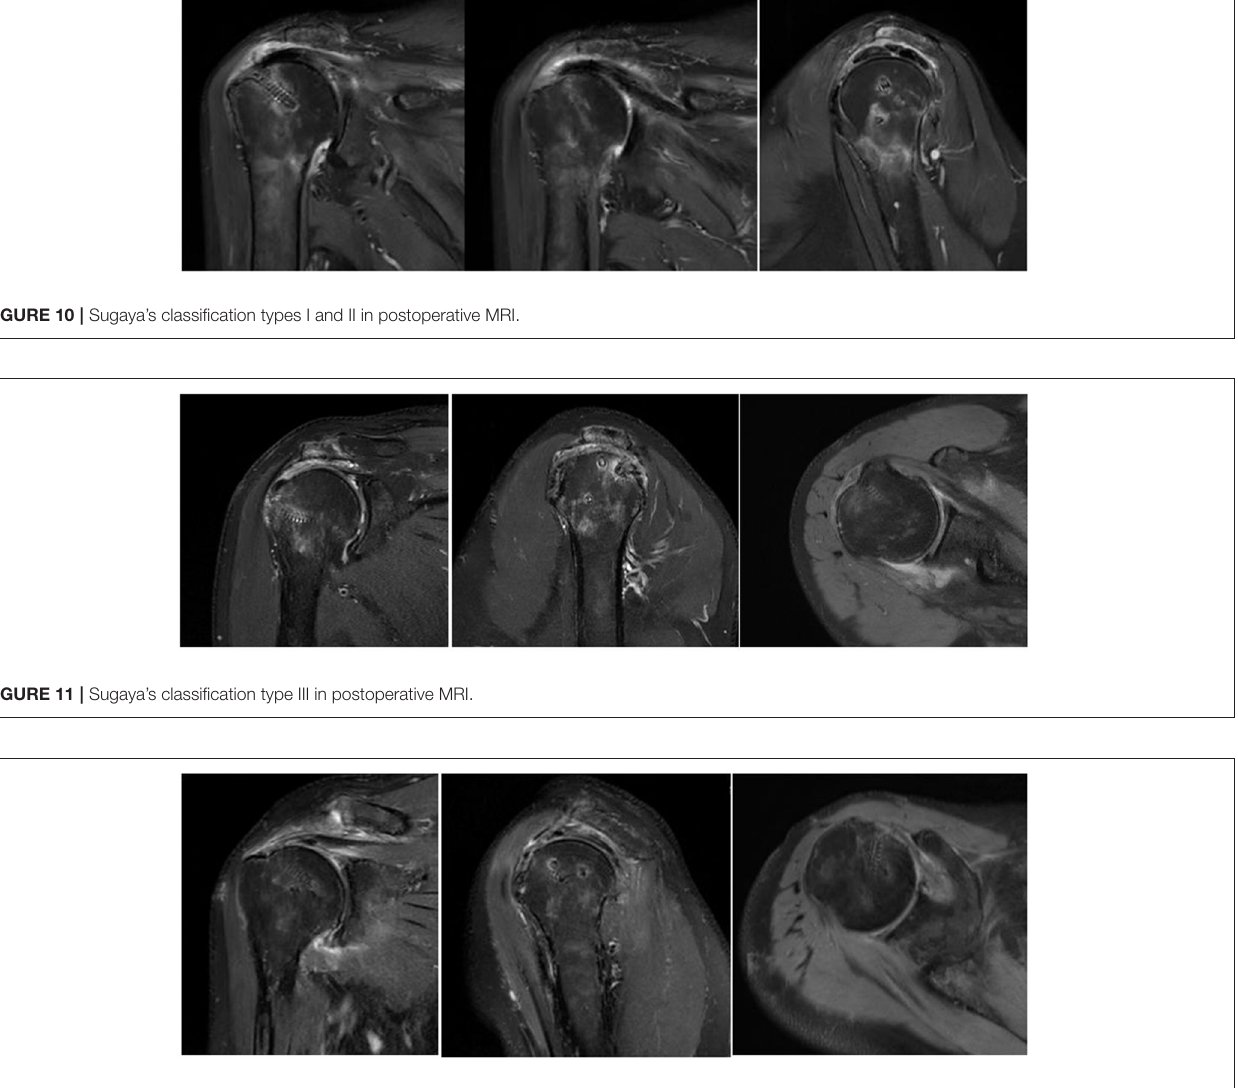
FIGURE 12 | Postoperative MRI images of the control